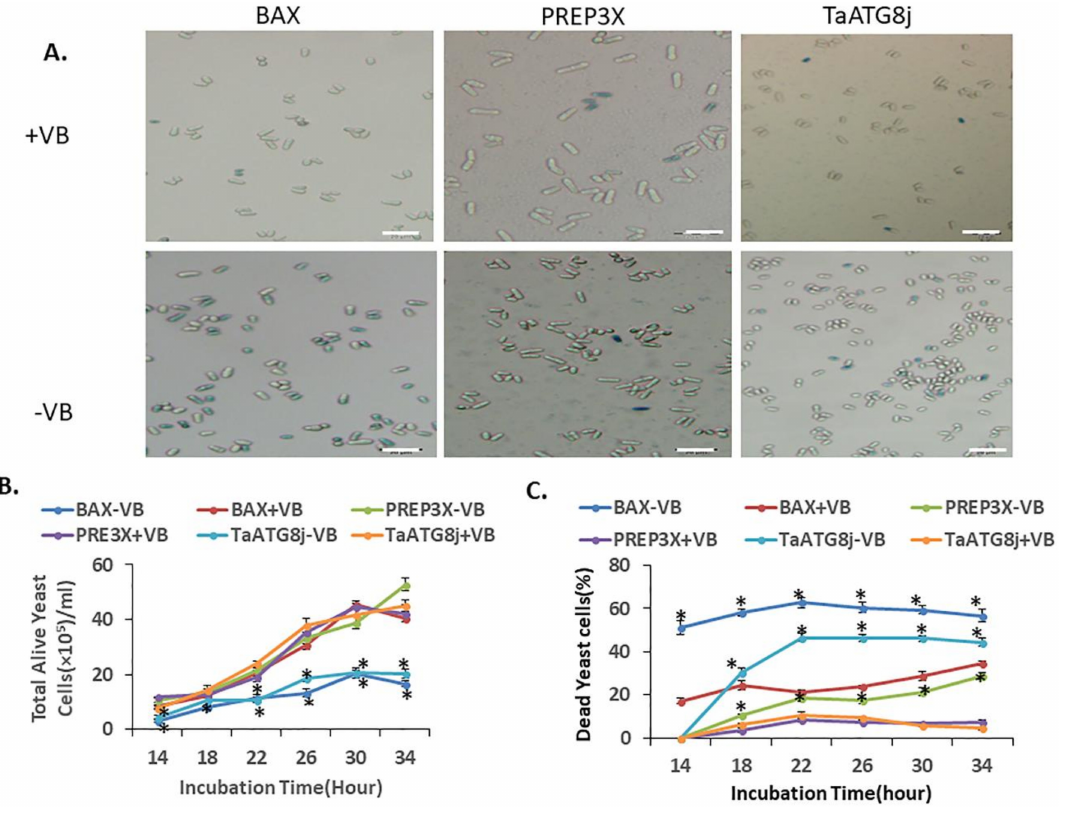
Figure 6. Overexpression of TaATG8j in yeast cells. The mouse pro-apoptotic BAX gene and pREP3X empty vector were used as positive and negative controls, respectively. Thiamine (VB) and trypan blue were used for repression and as a staining medium, respectively. The yeast cells were counted using a hemocytometer. Three biological replicates were performed. The yeast cell number mL − 1 was calculated at 14, 18, 22, 26, 30 and 34 h post-incubation. Incubation was started from an identical OD 600 : 0.2 using ± VB. ( A ) Phenotypically dead and alive yeast cells were compared by staining trypan blue staining using ± VB after expressing pREP3X_TaATG8j, pREP3X_BAX, or pREP3X. The dead yeast cells were stained blue. Bar: 20 µ m; ( B ) The total number of cells mL − 1 was counted. Yeast cells expressing the total number of alive and dead yeast cells of TaATG8j and BAX were significantly altered compared to the control; ( C ) The percentage (%) of the dead yeast cells of the total cells was calculated. Yeast cells expressing in TaATG8j or BAX showed more cell death compared with the control. Mean data are presented, and error bars indicate the variations among the biological replicates. Asterisks indicate the level (* p < 0.01) of significance without thiamine (VB) using Student’s t